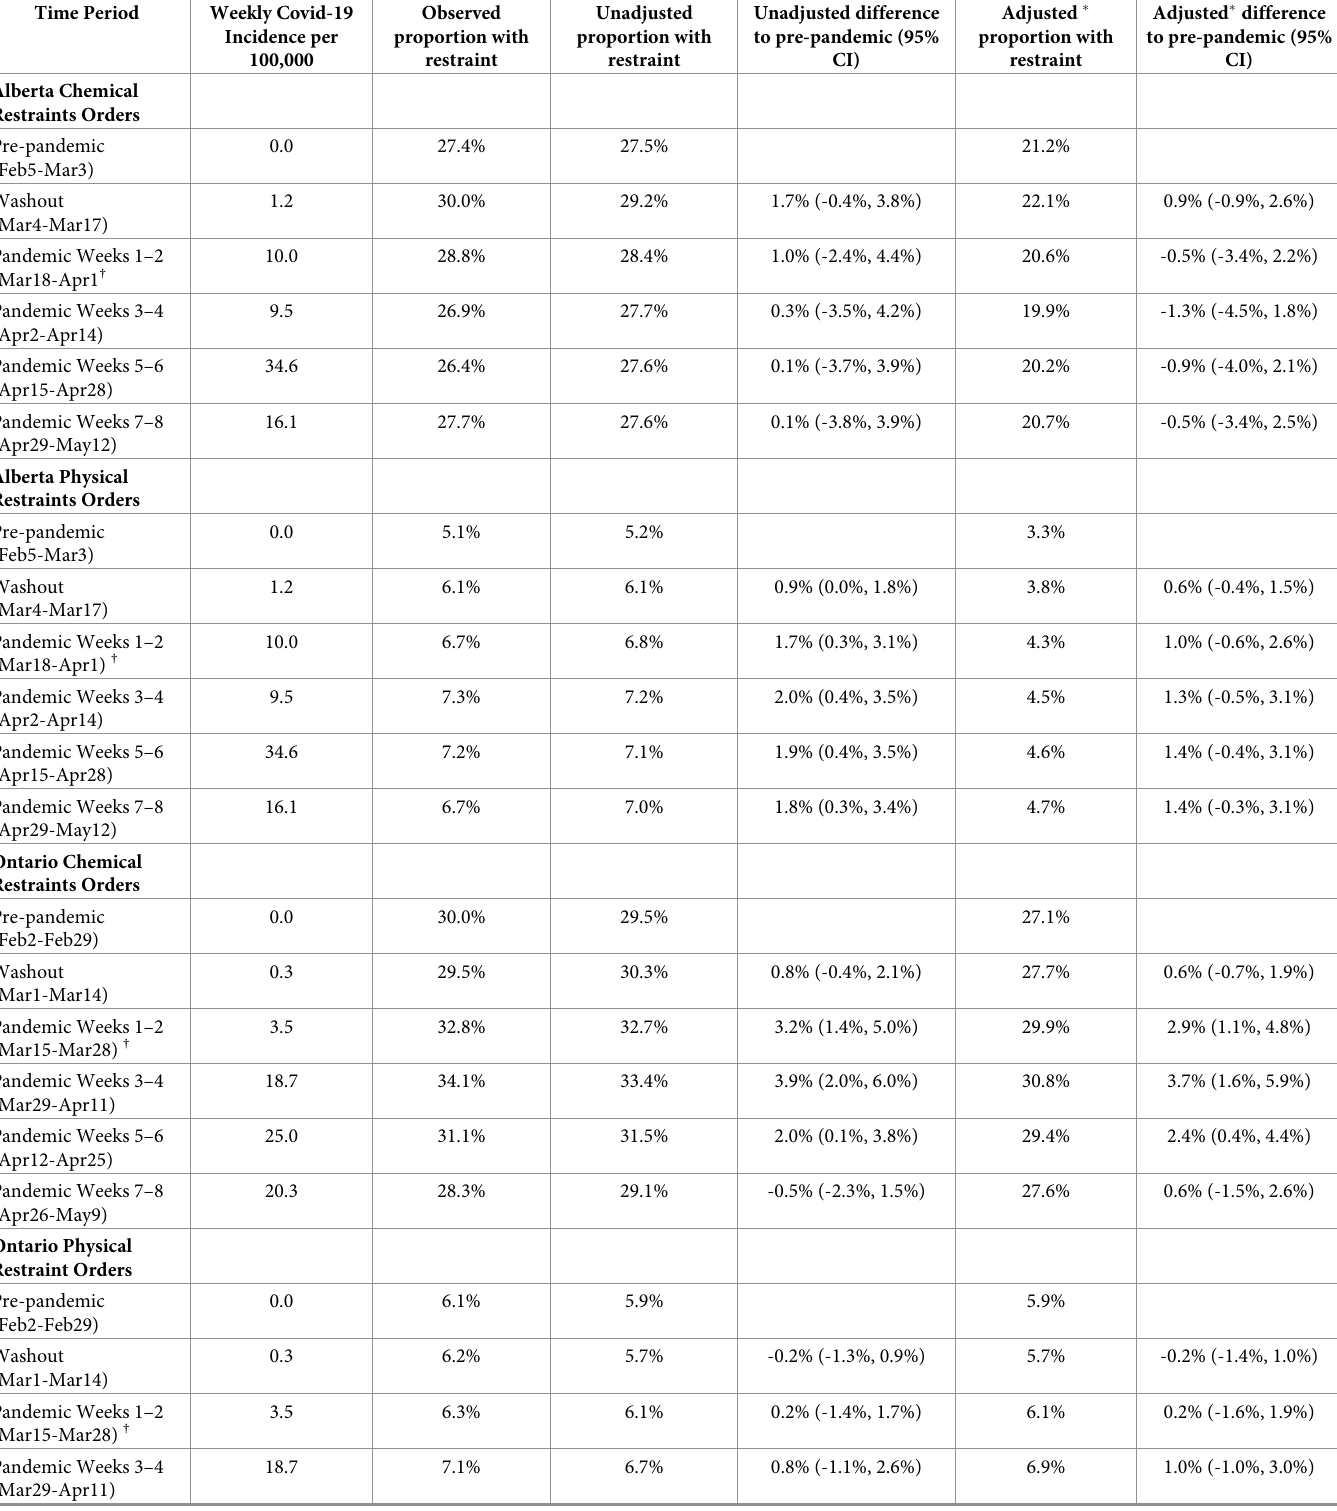
Table 2. In-hospital use of chemical and physical restraints among older adults at the onset of the COVID-19